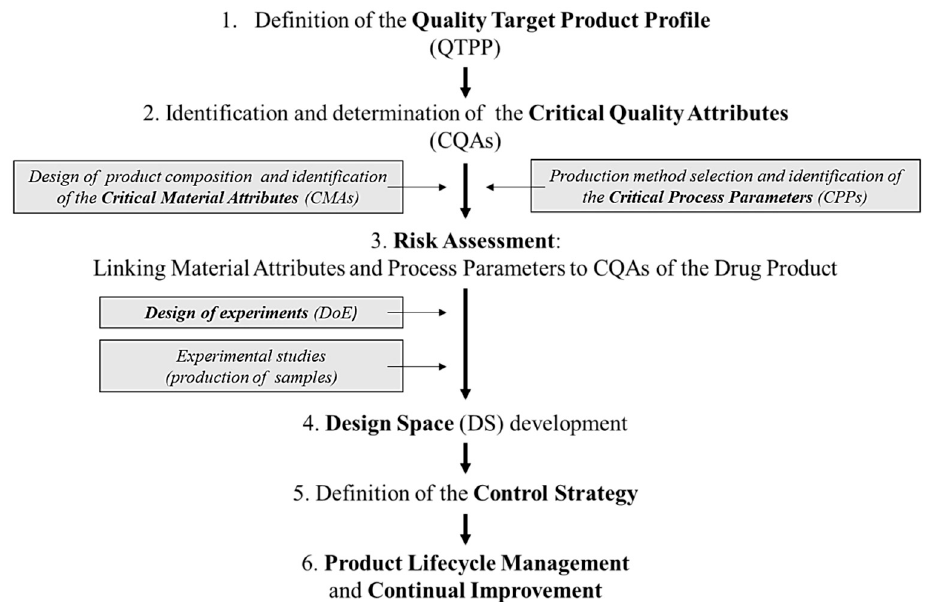
Figure 1. Schematic structure of the quality by design (QbD) approach. Table 1. Potential methods to prepare